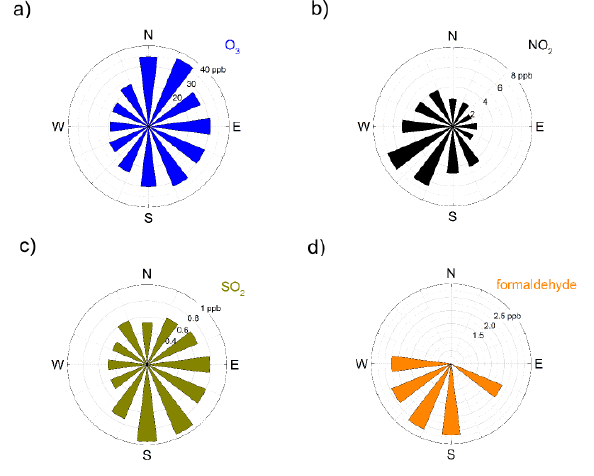
Figure 2. Wind rose depictions of median mixing ratio of (a) O 3 , (b) NO 2 , (c) SO 2 and (d) formaldehyde with respect to wind di- rection as measured by DOAS at Kenosha harbor from April to November of 2009. Medians are not reported for wind directions where few measurements ( n< 75 for 30min averaged data points) were above the detection limit (d.l.=1.5ppb for